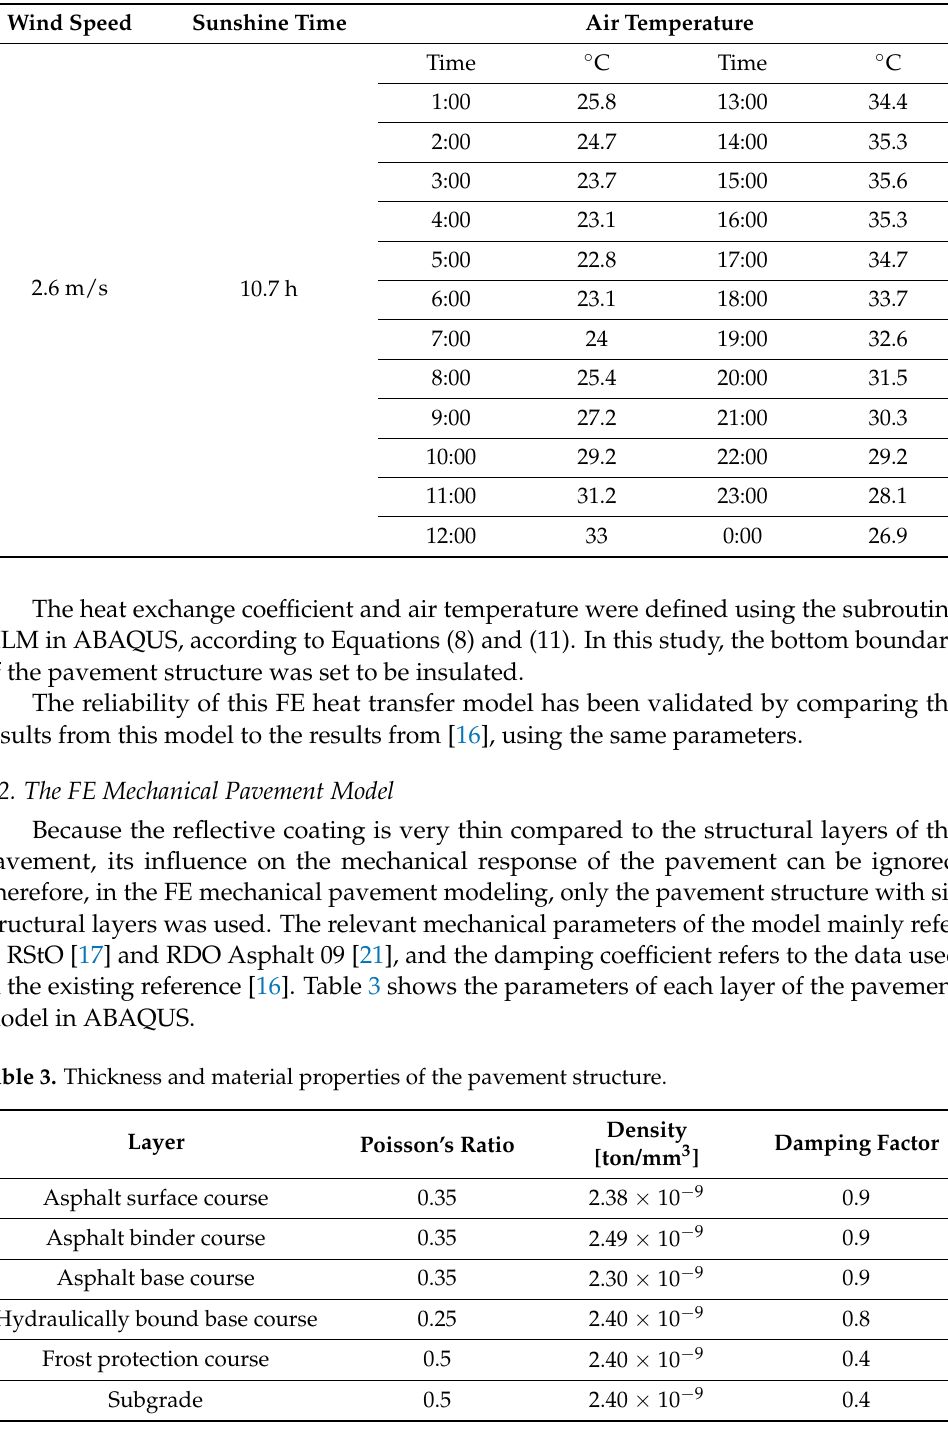
Table 2. Representative summer weather data used in the FE model [20].